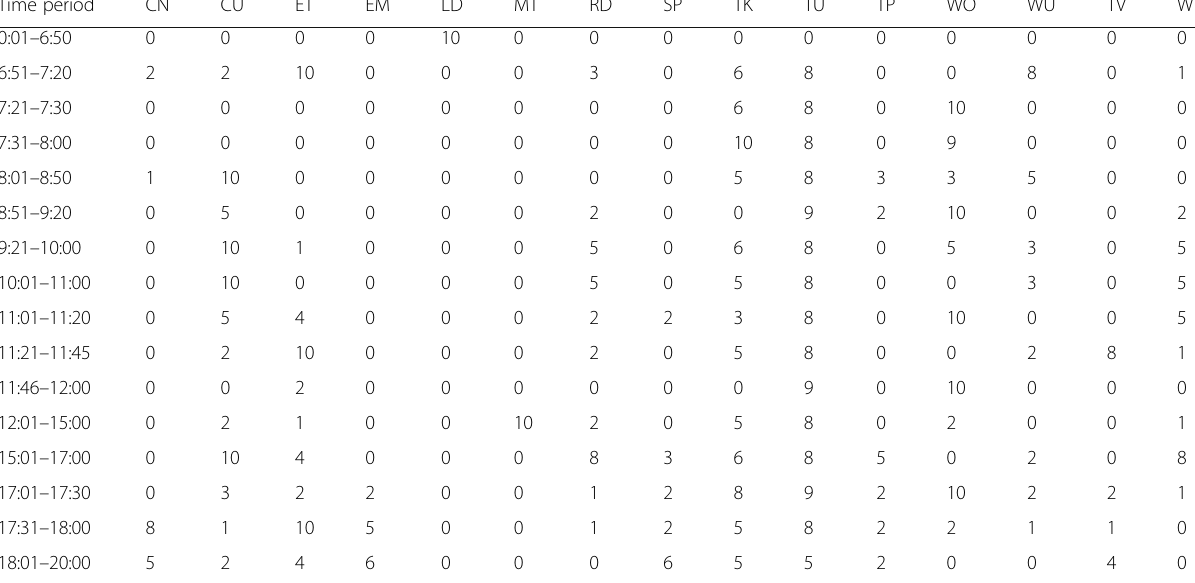
Table 14 Time – activity table for Friday (on this day a regular meeting present) for eButton wearer